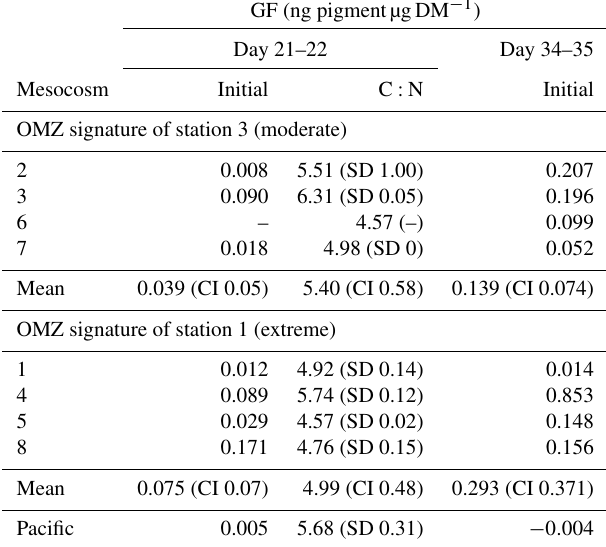
Figure 7. Biomass development (µgDML − 1 ) averaged for the moderate and extreme treatments over time of total copepods (a) and polychaetes (b) based on image analysis (ZooScan). Blue: moderate OMZ signature, red: extreme OMZ signature, black: Pa- cific. Error bars depict 95% confidence intervals. The green vertical dashed lines indicate the days of OMZ water additions. The experi- mental phase 1 lasted from day 1 until day 11–12, phase 2 until day 40, and phase 3 until experiment termination. Note the different y - axis scale.